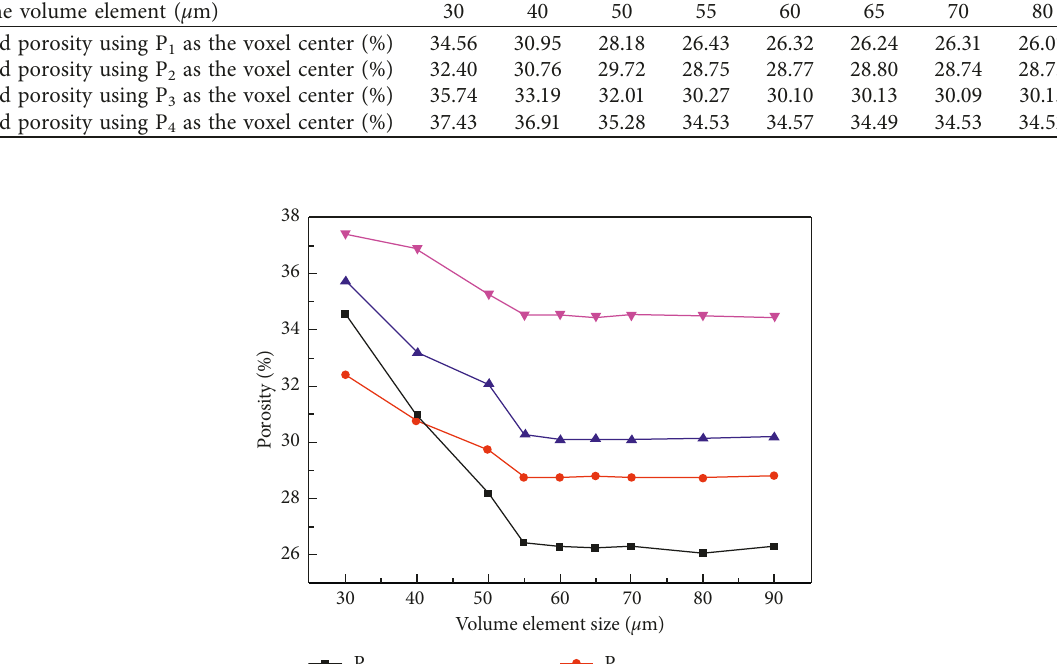
Figure 4: Variations of the calculated porosity with the increase of volume element size for different models.